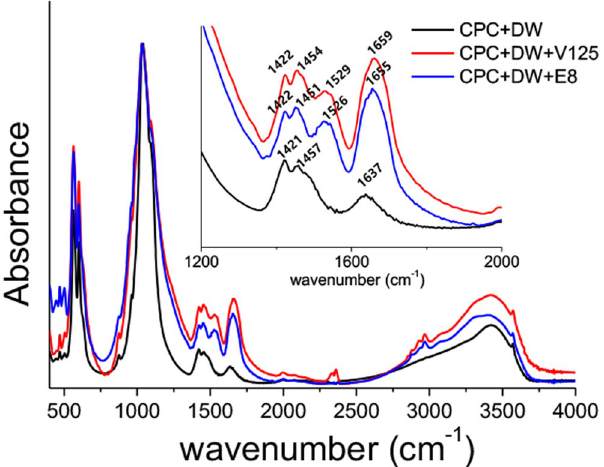
Figure 4. FT-IR analysis. The IR spectra of V125 and V125-E8 showed peaks characteristic of polypeptides, including amide I (1656 cm − 1 ) and amide II (1525 cm − 1 ), asymmetric sp3 CH2 (2965 cm − 1 ), symmetric sp3 CH2 (2875 cm − 1 ), and OH (3307 cm − 1 ). The peaks around 2300 cm − 1 in CPC with V125 indicates CO 2 or H 2 O in the air, which was not removed by background compensation